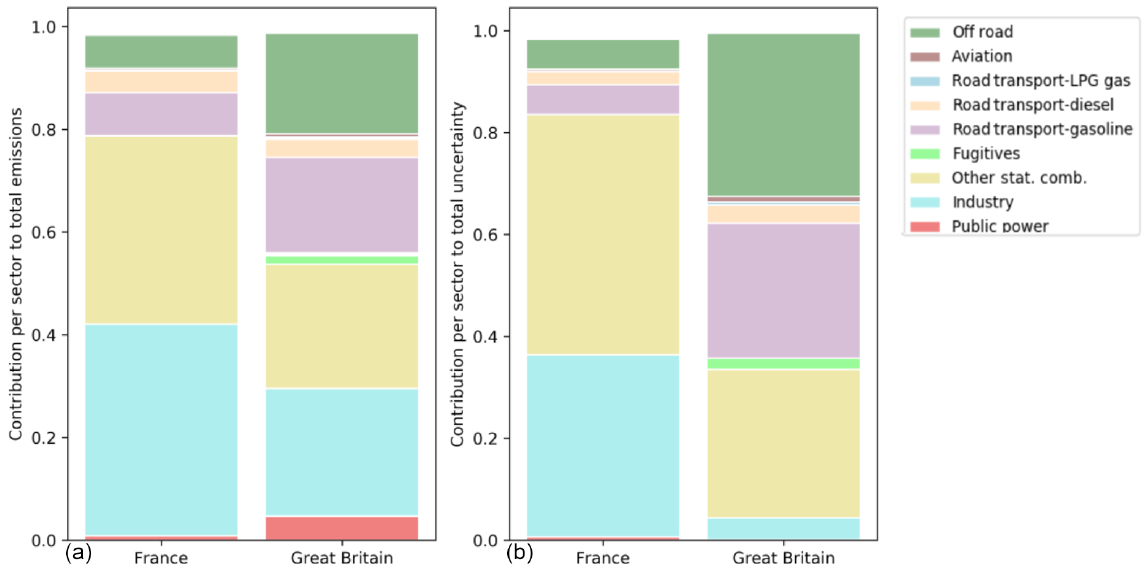
Figure 18. Contribution of source sectors to the total emissions (a) and the total uncertainty (b) in CO for France and Great Britain, summing to